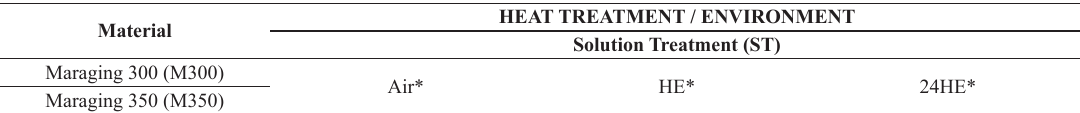
Table 2. Categorized of specimens tested on SSRT.